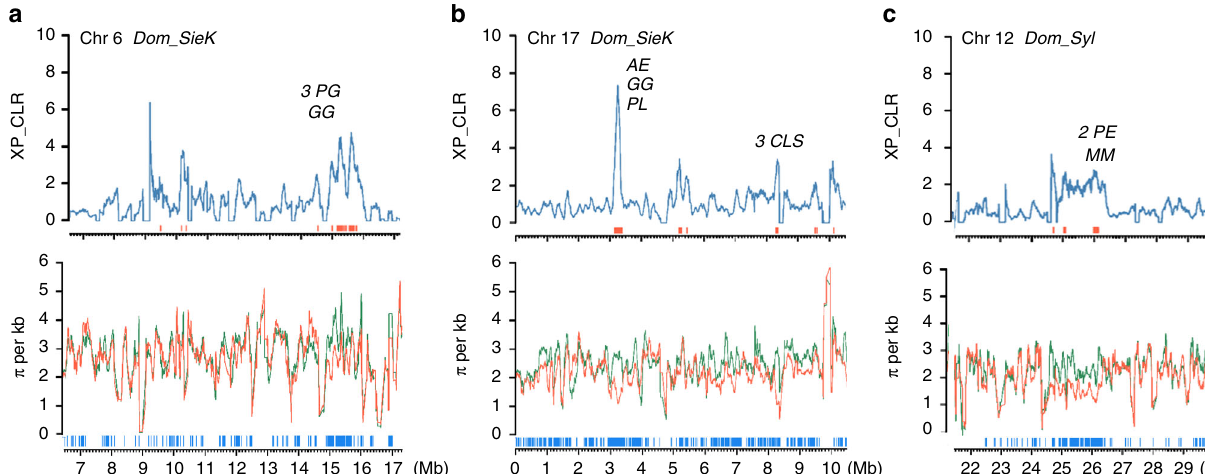
Fig. 5 Domestication sweeps underlying apple fruit fi rmness. Distributions of XP-CLR scores and nucleotide diversity ( π ) in selective regions on chromosomes 6 ( a ) and 17 ( b ) in M. domestica from M. sieversii in Kazakhstan ( Dom_SieK ) and chromosome 12 ( c ) from M. sylvestris ( Dom_syl ), which harbor genes known to be associated with fruit fi rmness. Distributions of XP-CLR scores are shown in top panels with selective sweeps marked with red bars and interesting genes labeled above peaks. Distributions of π are shown in bottom panels with M. domestica in orange lines , and M. sieversii and M. sylvestris in green lines . AE aldose 1-epimerase, CLS cellulose synthase, GG glucan endo-1,3-b-glucosidase, MM endo-beta-1,4-mannase, PE pectinesterase, PG polygalacturonase, PL pectate